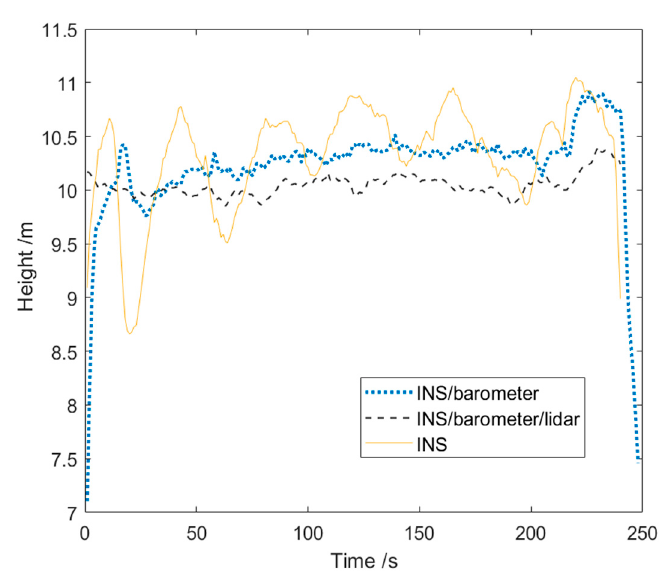
Figure 11. Comparison of the multi-sensor height control of the quadrotor above flat terrain.